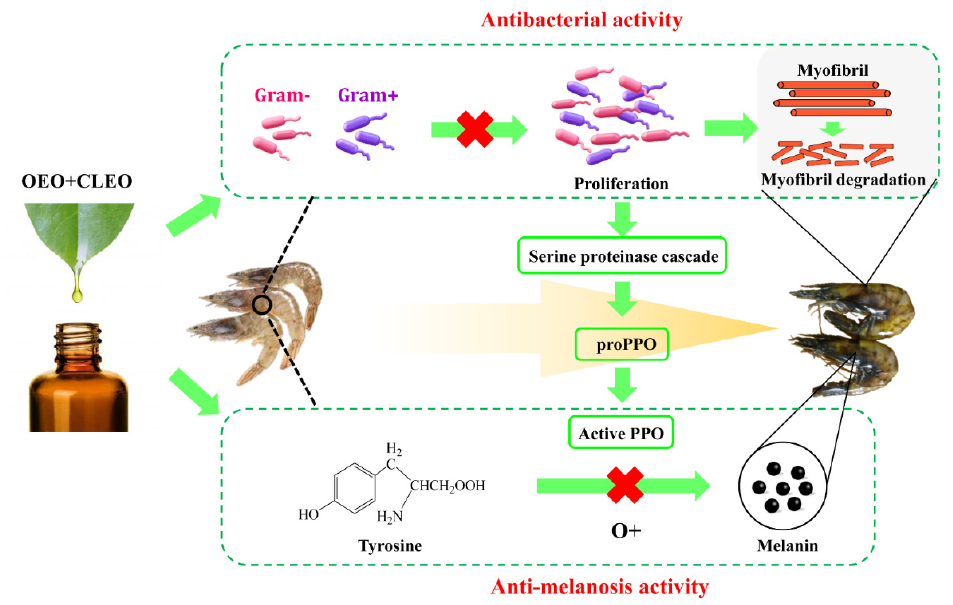
Figure 5. Schematic diagram of the antibacterial and anti-melanosis activity of OEO + CLEO on Pacific white shrimp during cold storage.